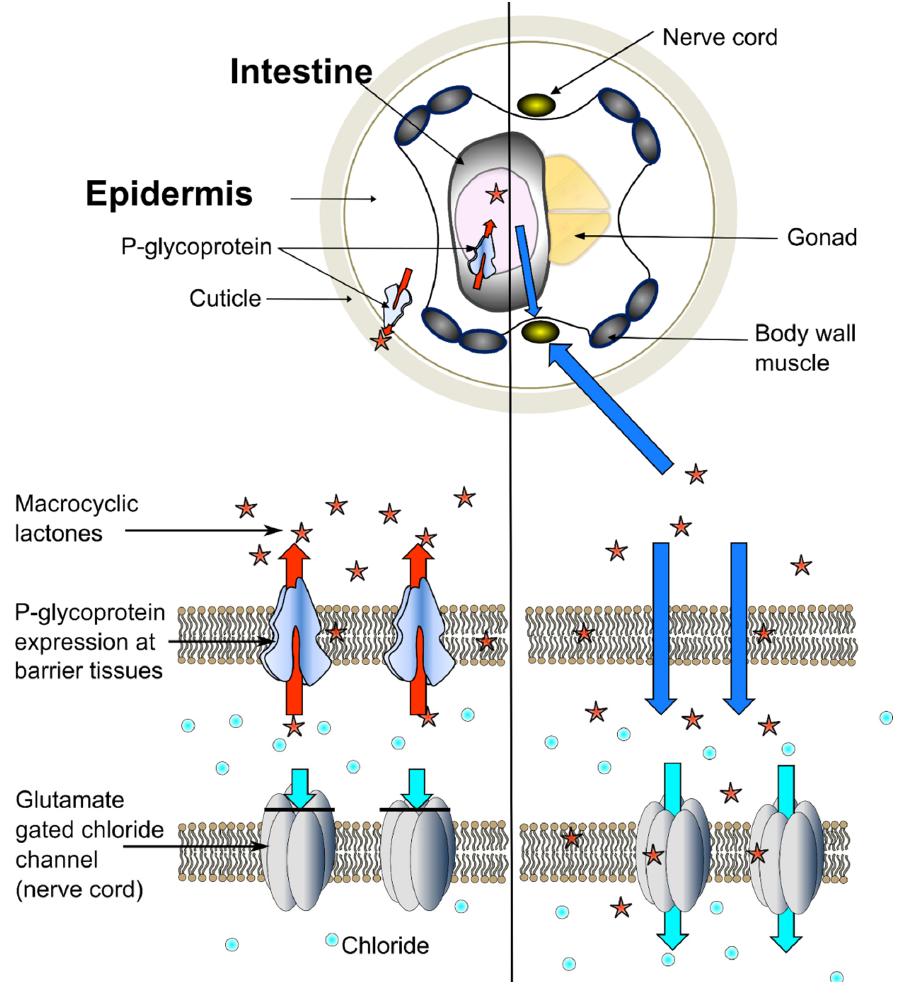
Figure 5. Schematic illustration of P-glycoprotein-mediated barrier function. Hypothetical schematic illustration of Pgp-mediated barrier function in a Caenorhabditis elegans adult. Expression of P-glycoproteins in specific barrier tissues, i.e., the epidermis and the intestine prohibit MLs from reaching target tissues, thereby preventing an ML-induced hyperpolarisation of the neurons and muscle paralysis.